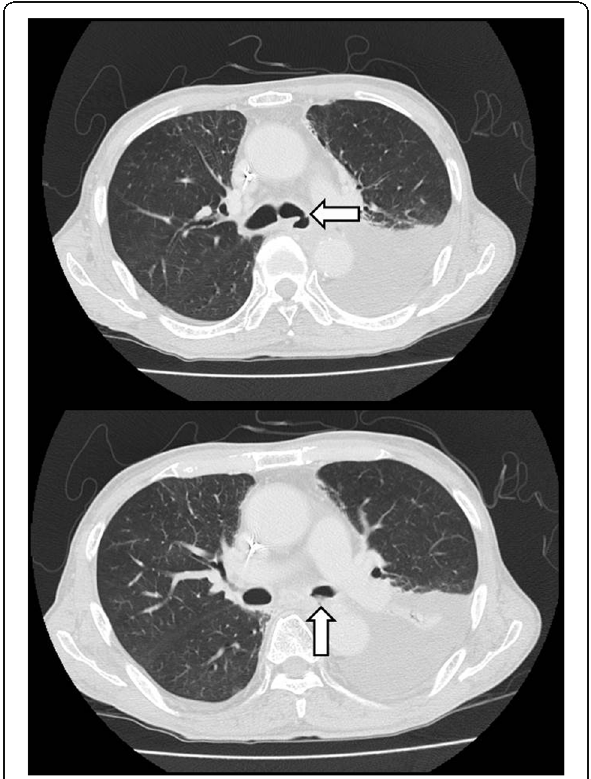
Fig. 1 Preoperative computed tomography revealed two esophagobronchial fistulae ( arrows ) at the left main bronchus and pleural effusion in the left thoracic